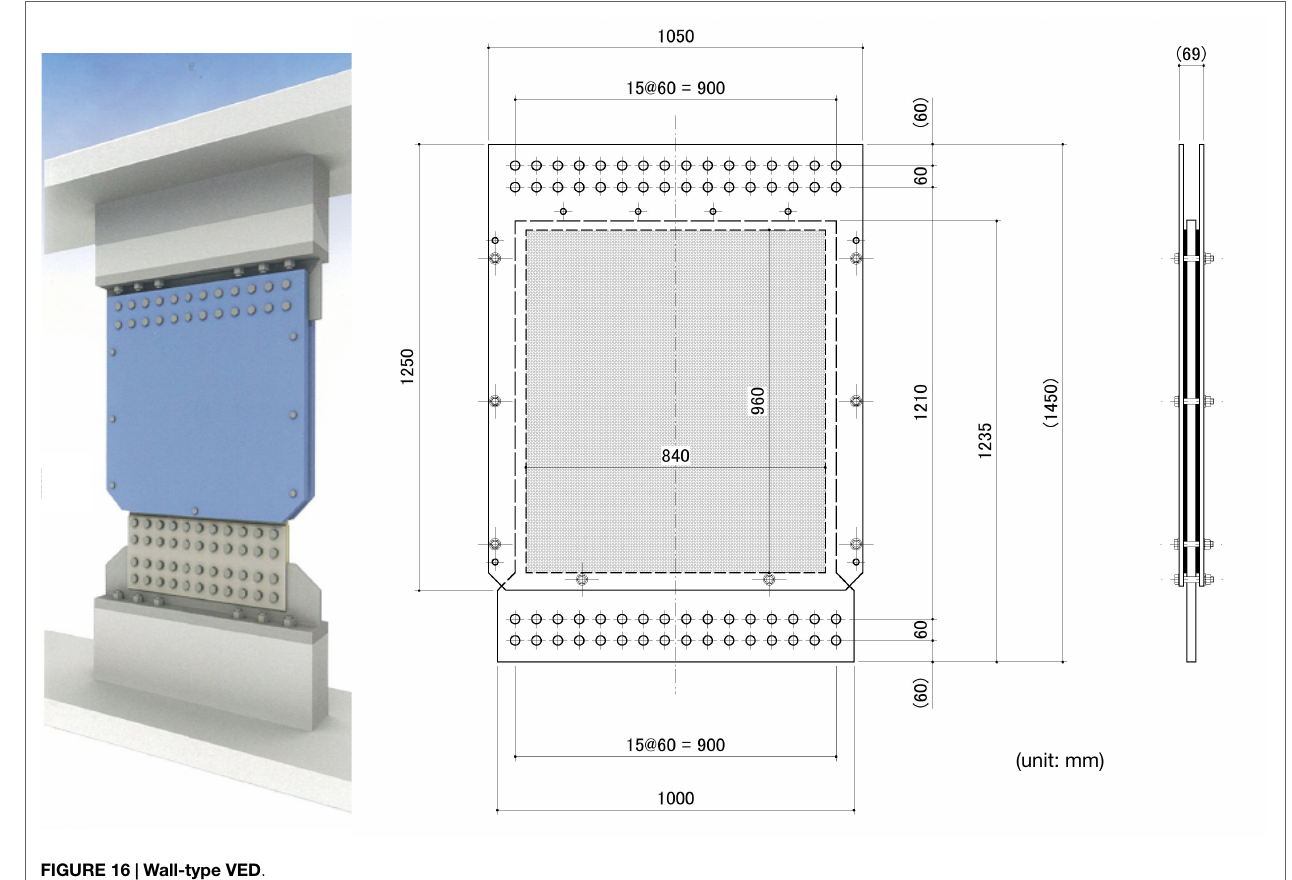
FIGURE 16 | Wall-type VED .